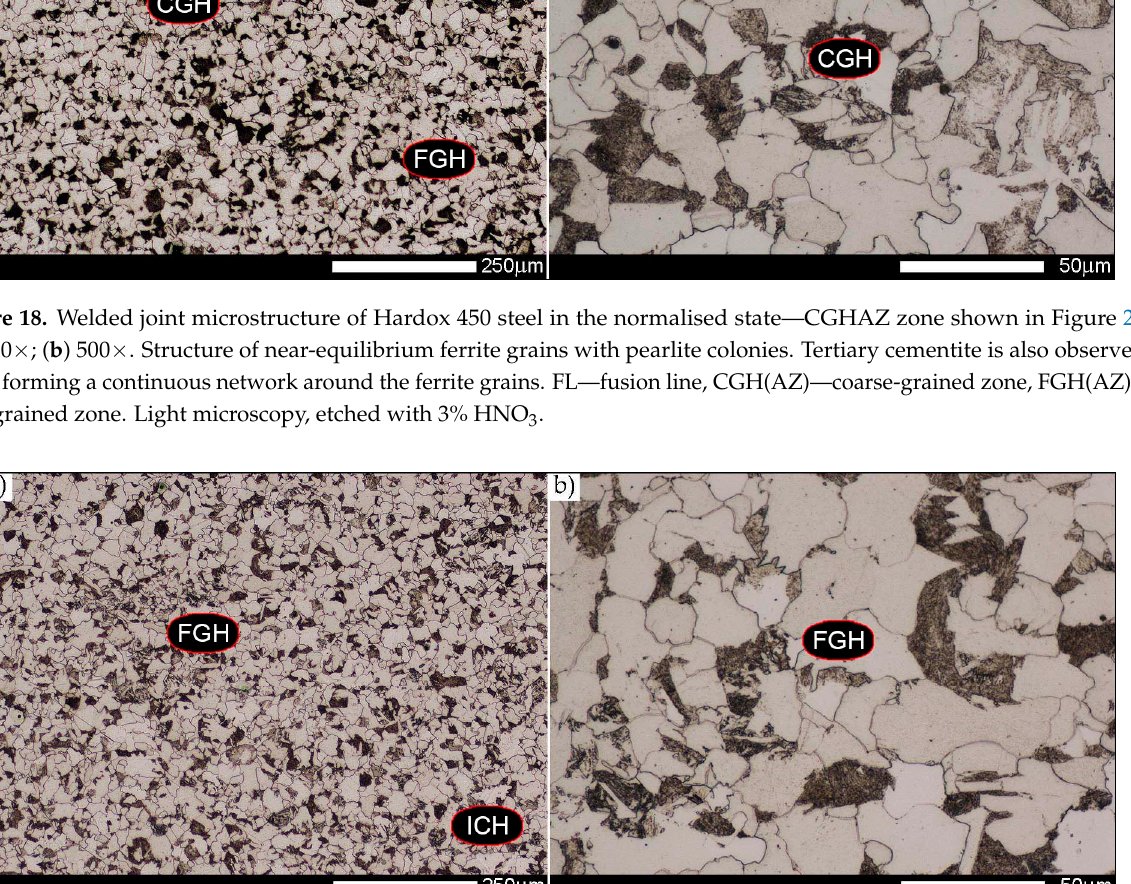
Figure 19. Welded joint microstructure of Hardox 450 steel in the normalised state—FGHAZ zone shown in Figure 2b. ( a ) 100×; ( b ) 500×. Structure of near-equilibrium and non-equilibrium ferrite grains with pearlite colonies. On the borders of the ferrite grains, precipitates of tertiary cementite are also observed. FGH(AZ)—fine-grained zone, ICH(AZ)—intercritical zone. Light microscopy, etched with 3% HNO 3 .